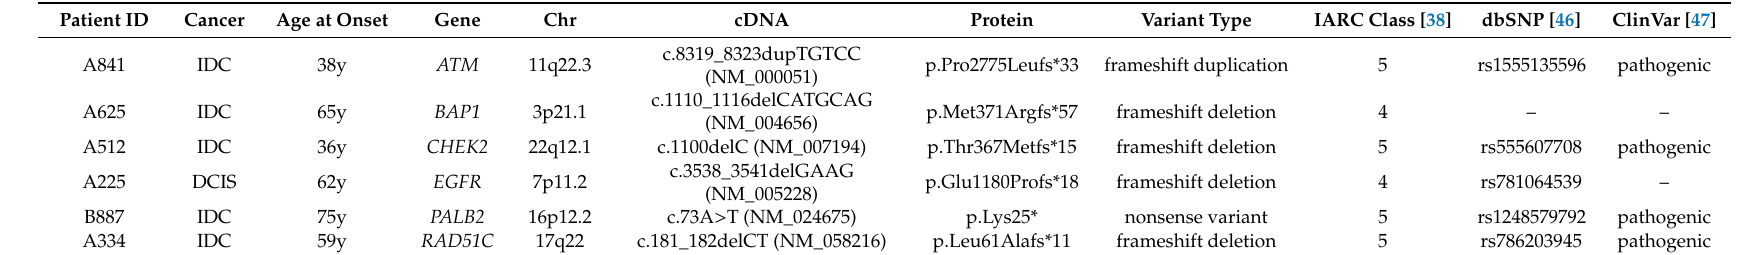
Table 3. Carriers of pathogenic and likely-pathogenic variants in genes other than BRCA1 / 2